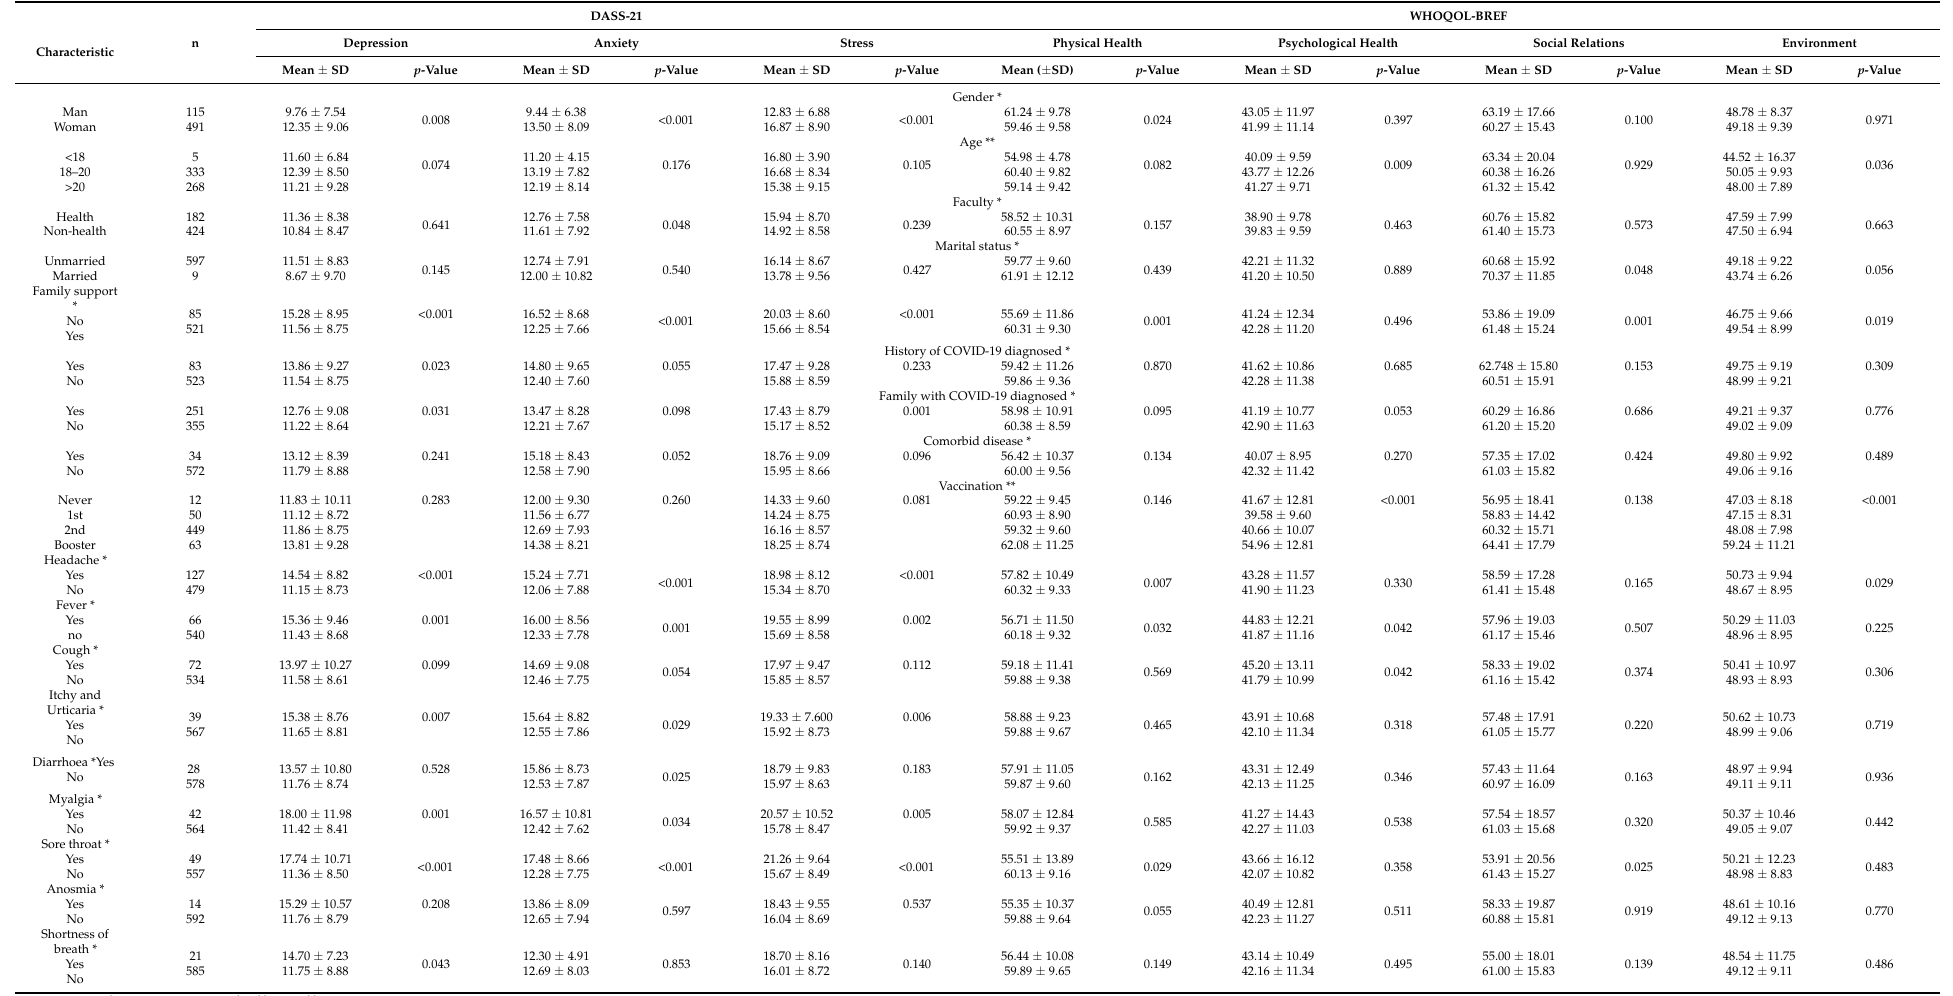
Table 6. Association of demographic characteristics and depression, anxiety, stress, physical health, psychological health, social relations, and environment. DASS-21